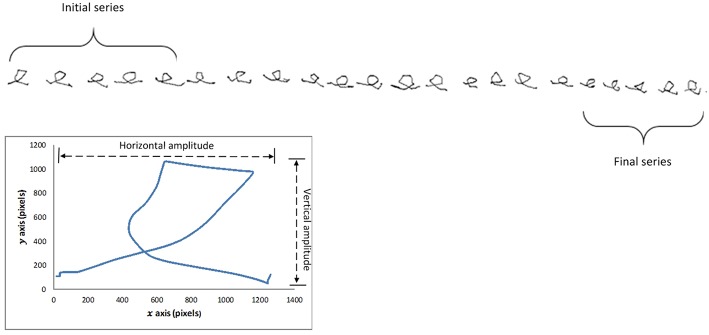
Letter e sequence from subject with progressive micrographia, showing selection of first and last five letters. Enlarged single letter illustrates the relationship between stroke length and horizontal and vertical amplitudes.